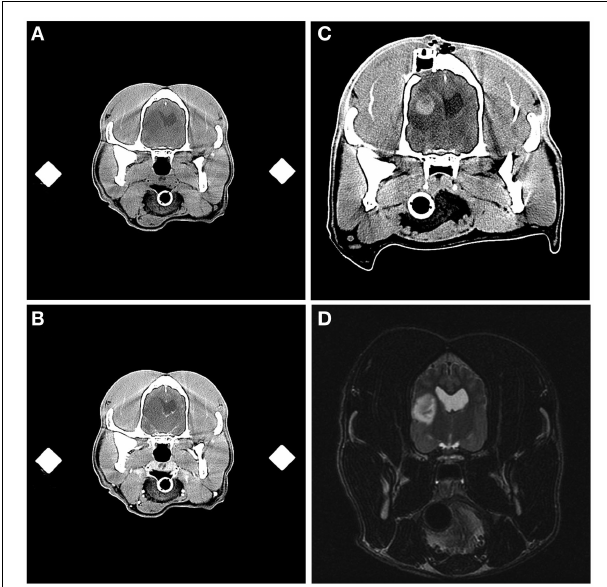
FIGURE 6 | Intracranial hemorrhage resulting from frame-based stereotactic biopsy of a Grade III oligodendroglioma . Transverse, pre- (A) and post-contrast (B) stereotactic planning CT scans demonstrating hypoattenuating and non-enhancing mass lesion in the temporal region. On the immediate post-biopsy, pre-contrast CT scan, biopsy-induced intracranial hemorrhage is apparent as an ovoid, hyperattenuating lesion contained within the dorsal and central aspect of the previously described hypoattenuating mass (C) . The craniectomy and implanted catheter guide pedestal